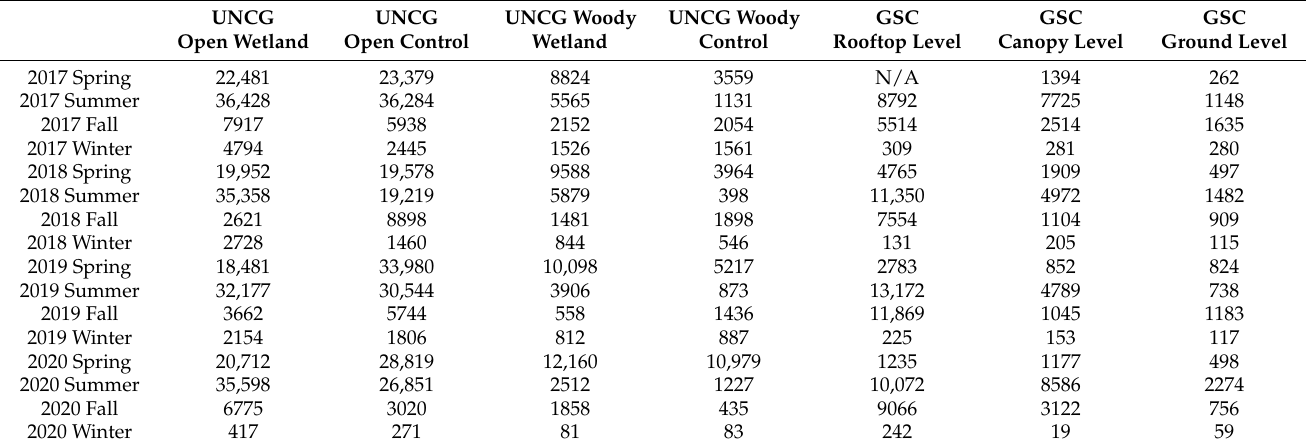
Table 1. Total bat passes recorded at each study site in each season in Greensboro, NC, USA. UNCG UNCG Open Wetland Open